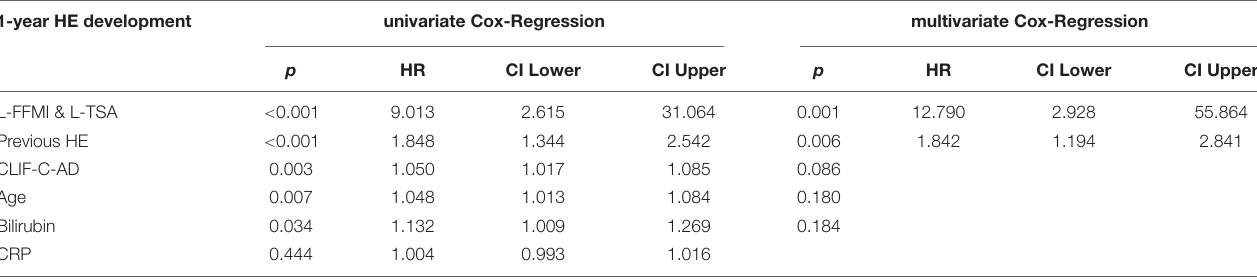
TABLE 4 | Univariate/multivariate Cox regression analysis for 1-year HE development comparing lower fat-free muscle index (L-FFMI) and large-total portosystemic shunt area(L-TSA) classification with high fat-free muscle index (H-FFMI) and small-TSA (S-TSA) classification. 1-year HE development univariate Cox-Regression multivariate Cox-Regression